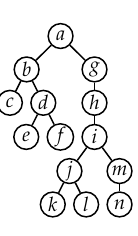
Figure 1. ( a ) A tree on which, in the Scotland Yard game, two detectives, Alice and Bob, suffice to catch a thief wherever he starts. The tree width of the tree, which is defined as the necessary number of detectives minus 1, is hence 1. ( b ) In contrasts, on a cycle, Alice and Bob must enlist the help of a third detective, Dave, to catch the thief. Hence, the tree width of a cycle is 2.